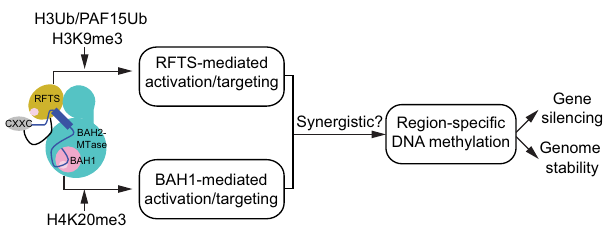
Fig. 6 A model for DNMT1 RFTS- and BAH1-regulated DNA methylation. Structural elements of DNMT1, including RFTS, CXXC, autoinhibitory linker and BAH1 are colored in corn, gray, blue and pink, respectively. The BAH2 and MTase domains are colored in cyan. Histone marks (H3K9me3 and H4K20me3) cooperate with UHRF1-generated H3Ub or PAF15Ub in activation and targeting of DNMT1 for optimal DNA methylation at speci fi c genomic loci, which in turn leads to gene repression and genomic stabilization. Note that the H3K9me3Ub and H4K20me3 marks likely regulate the activity of DNMT1 in a synergistic